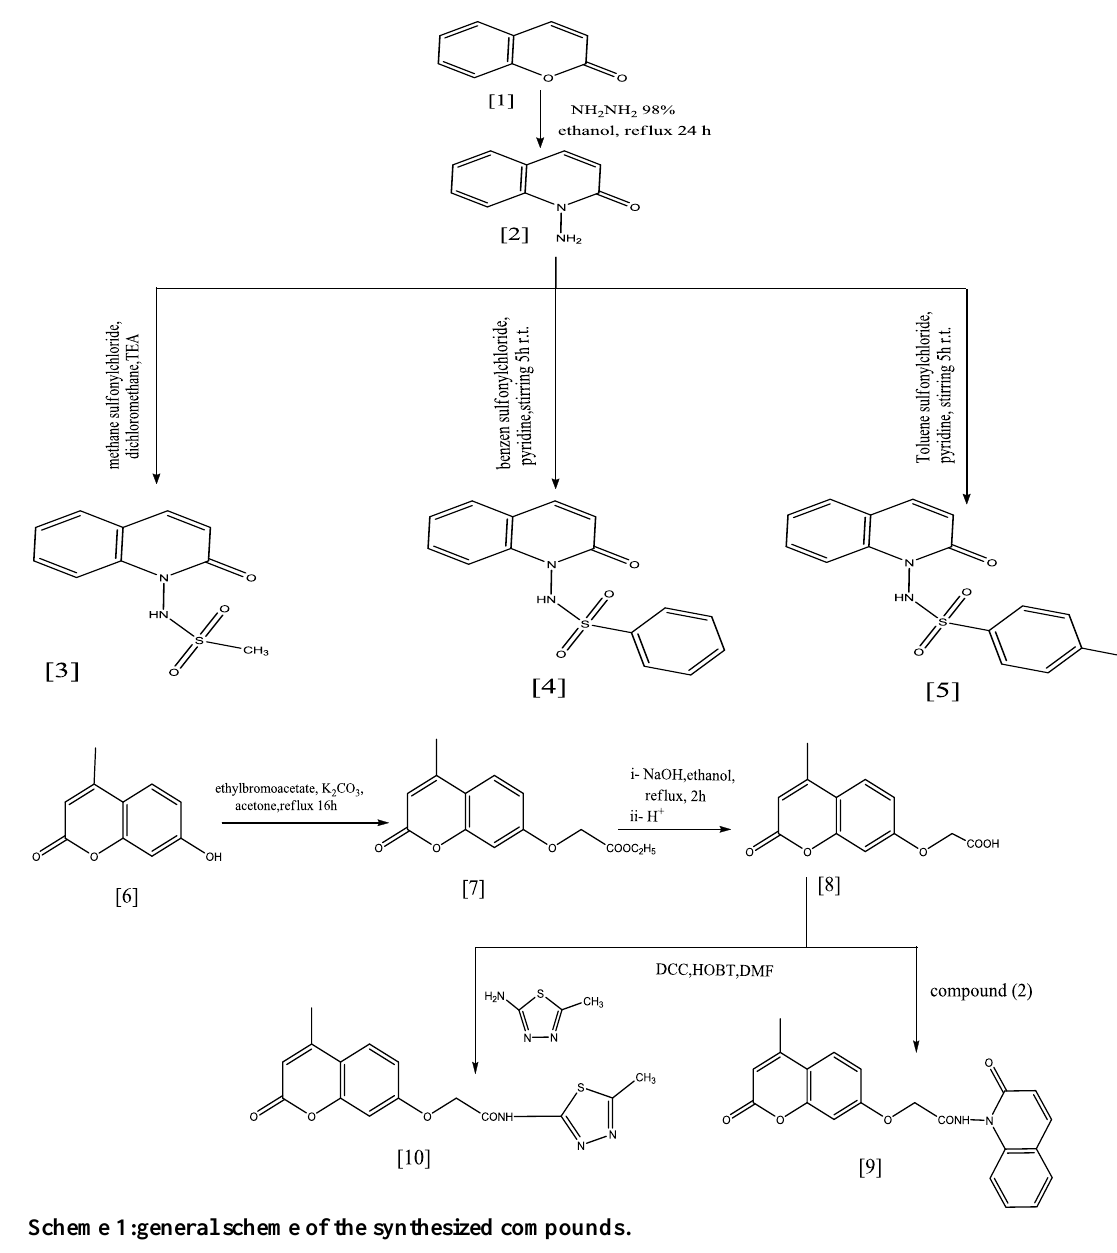
Scheme 1:general scheme of the synthesized compounds.